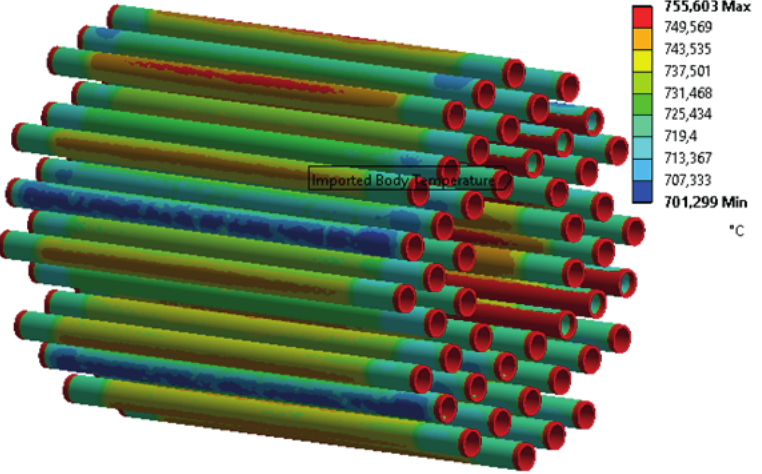
Figure 11: Temperature profiles in the MEA imported to the ANSYS Mechanical module